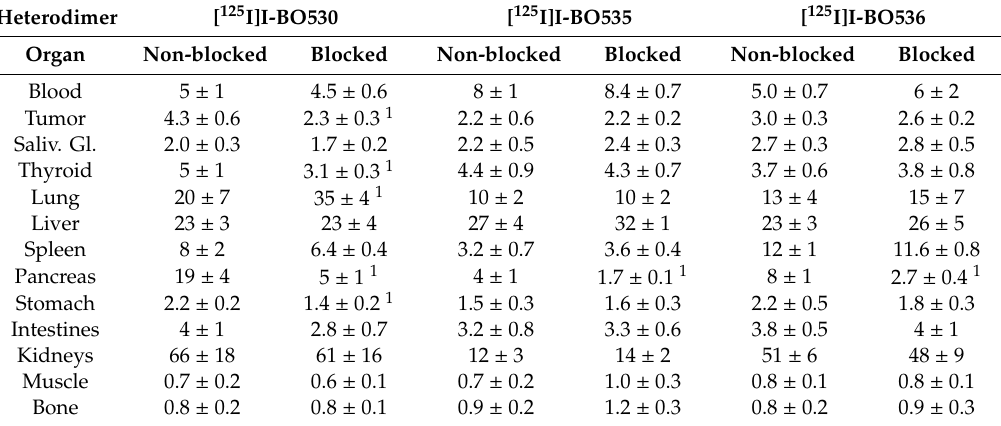
Table 1. In vivo specificity GRPR tested 1 h post injection (pi) of [ 125 I]I-BO530, [ 125 I]I-BO535, and [ 125 I]I-BO536 (%ID / g) . Balb / c nu / nu mice with PC-3 xenografts were injected with 40 pmol (30 KBq) of labeled heterodimer (non-blocked group). For the specificity test, the heterodimer was co-injected with 7.5 nmol of unlabeled RM26 (blocked group). Data are presented as mean value ± standard deviation. Heterodimer